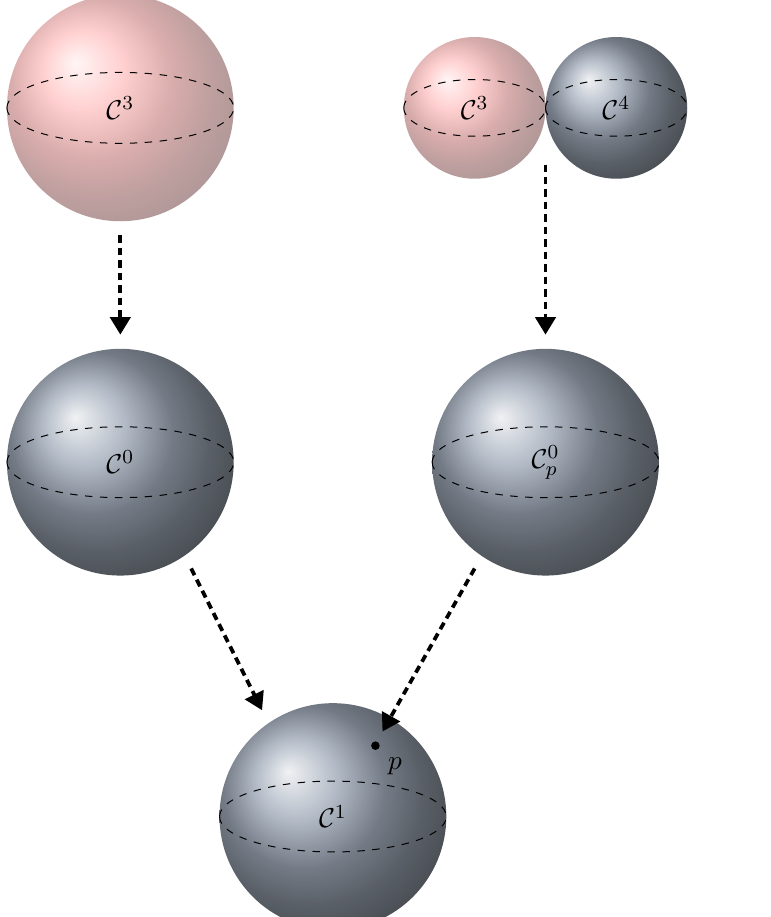
Figure 6. We show the base ˜ B 3 of a blow-up of the P 1 -fiber of a P 1 -fibration over F 1 . The zero section is in the darker